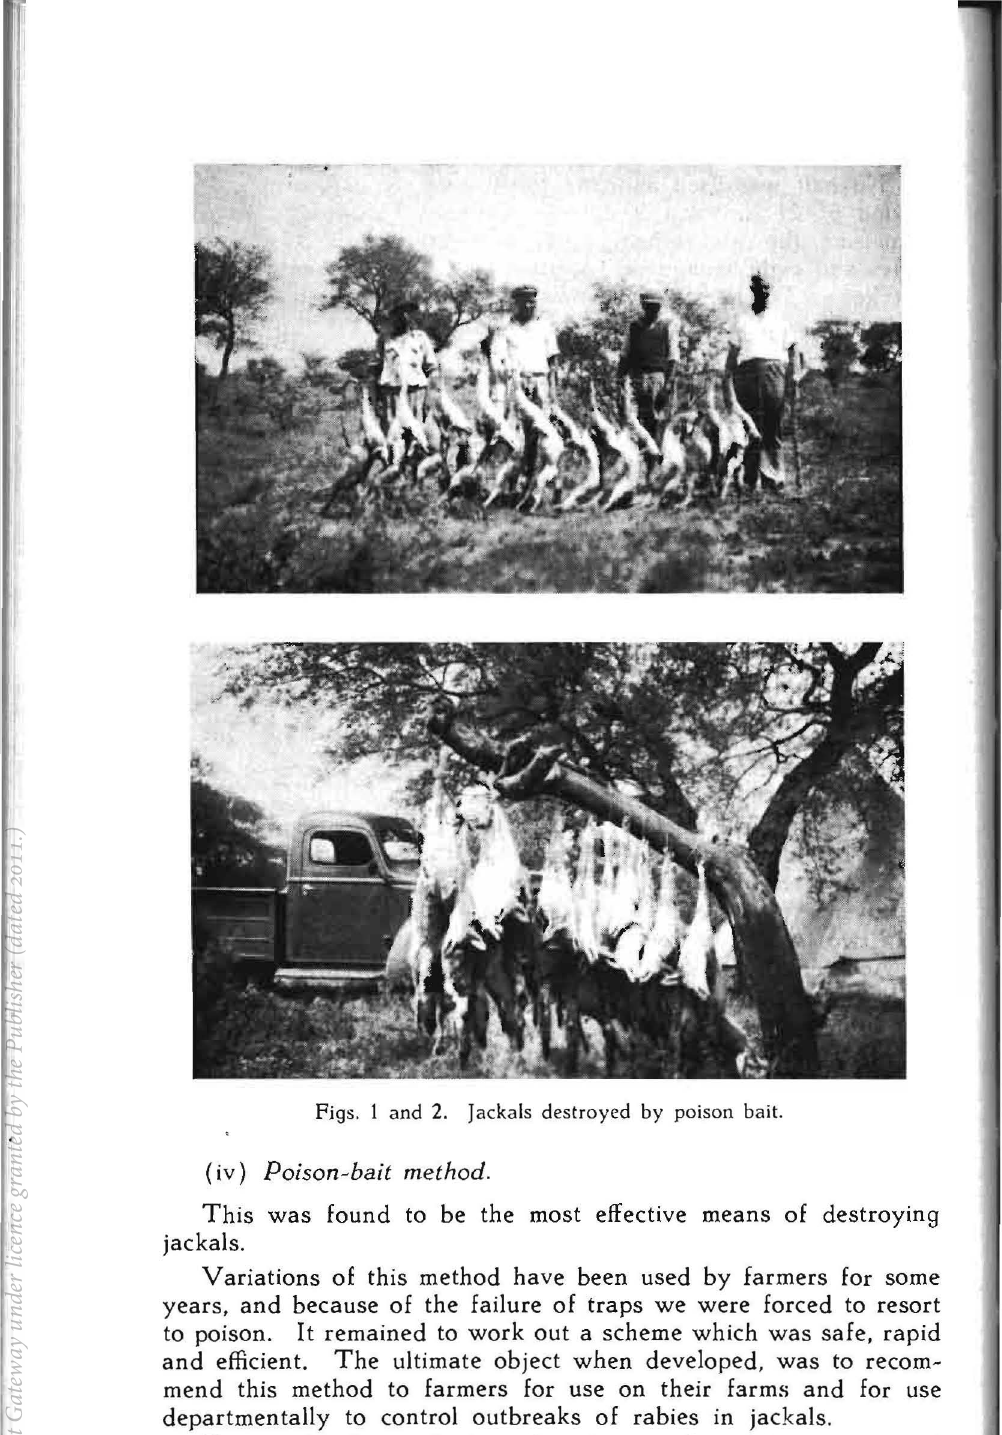
Figs. I and 2. Jackals destroyed by poison